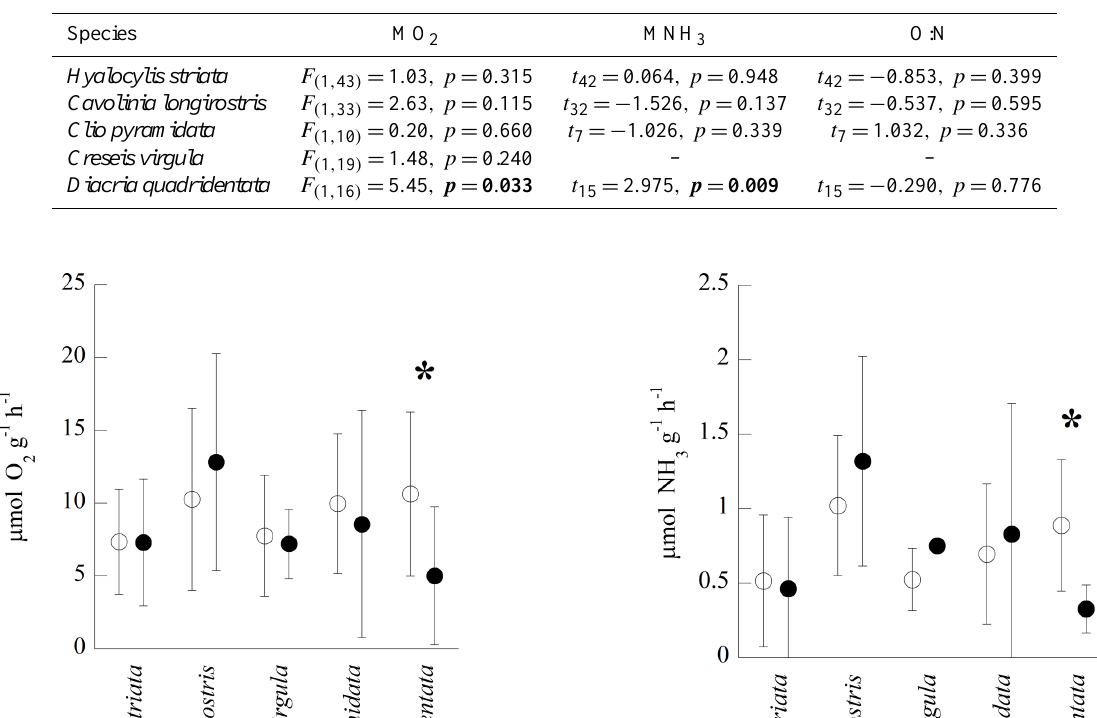
Table 5. Statistical analysis comparing the difference between groups exposed to 0.03% and 0.10% CO 2 (Table 4). Statistical analysis for O 2 consumption (dependant variable) was conducted using a one-way ANCOVA to account for the variation due to size (continuous variable). Analysis of NH 3 excretion and O:N ratio was conducted using a two-tailed t-test.